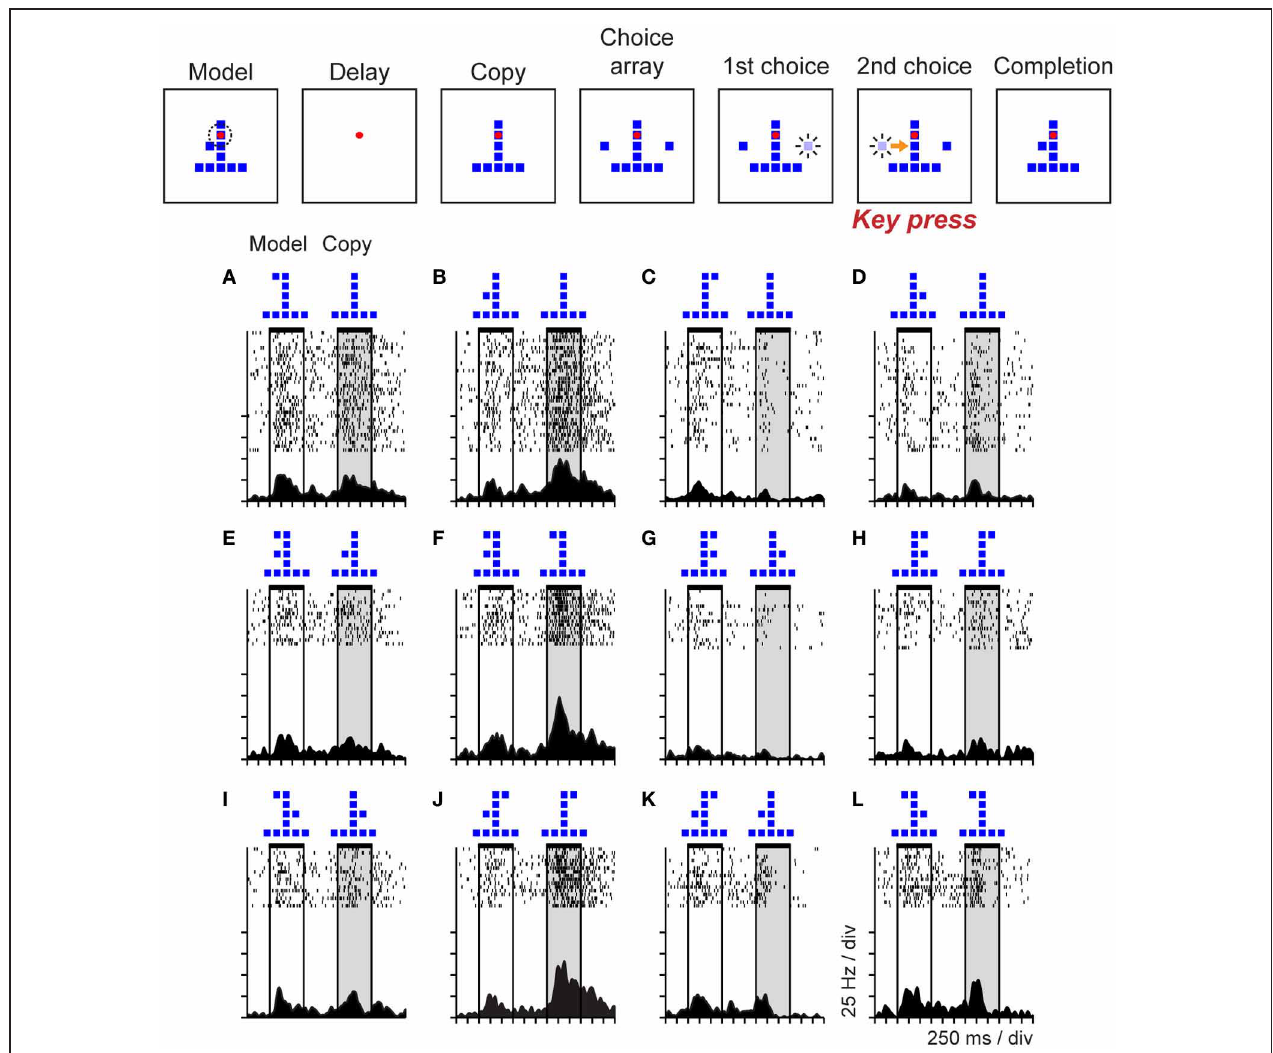
sequence. The monkey controlled which square was added by timing when it pressed asingle response keyinrelation to the choice sequence (the computer added the square that was bright at the time of response to the copy object automatically). (A–L) The duration of model and copy periods is delimited by horizontal black bars at the top of each raster. This neuron was activated primarily during the copy period, on trials in which the model and copy objects presented jointly localized the single square missing from the copy object (relative to the preceding model) to the middle left position within the